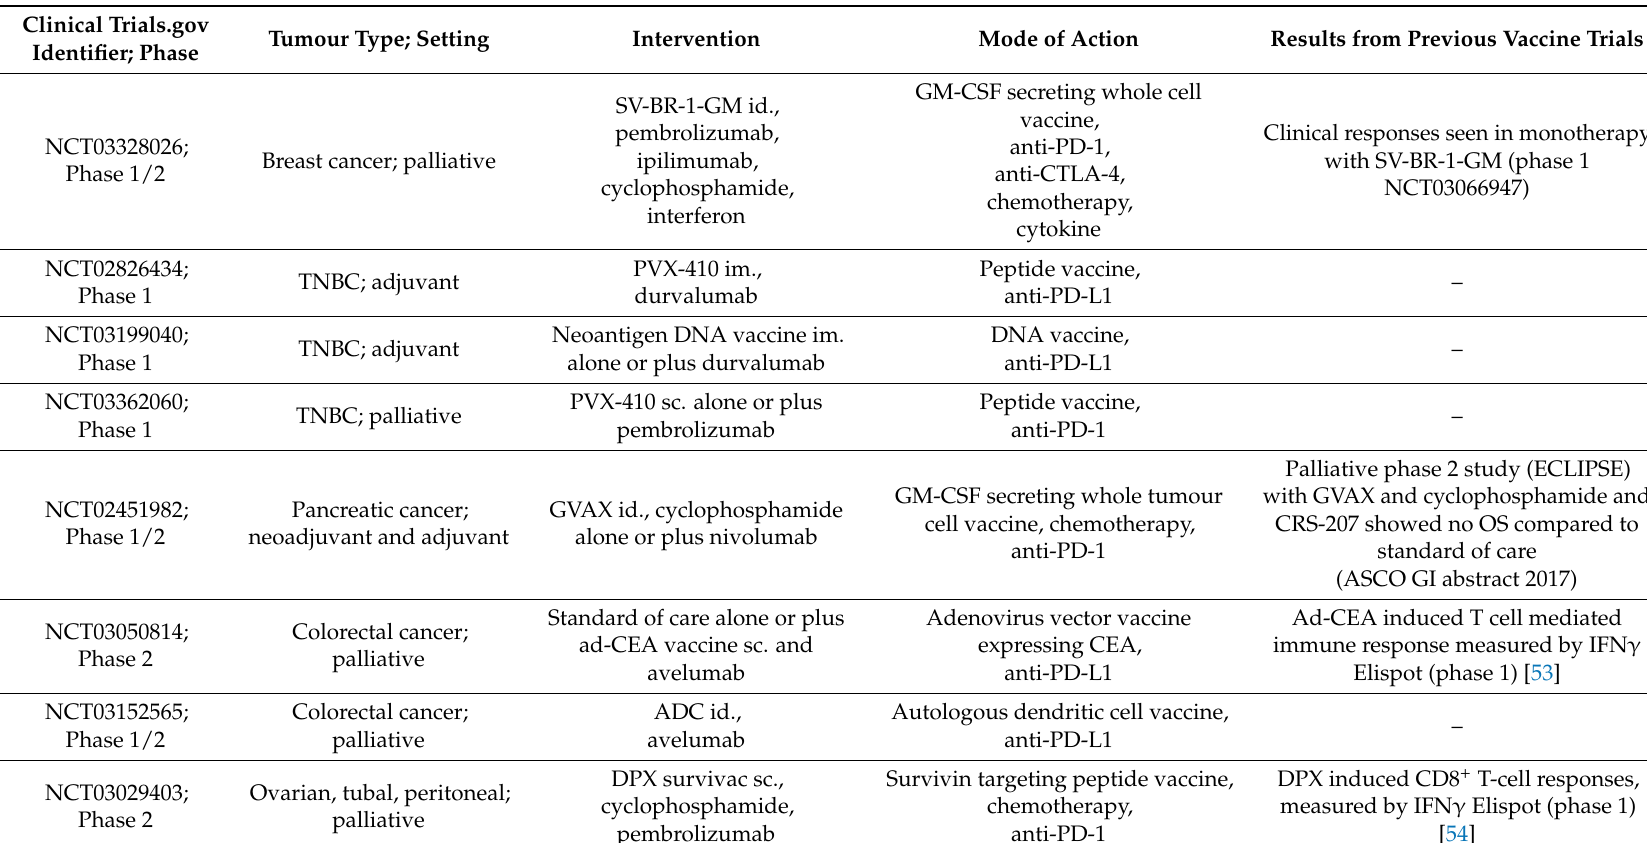
Table 2. Examples of clinical trials combining different type of cancer vaccines with checkpoint inhibitors. The result section gives an overview of results from earlier phase trials if data are available for the specific cancer type. Abbreviations: TNBC, triple negative breast cancer; NSCLC, non-small cell lung cancer; SCLC, small cell lung cancer; OS, overall survival; PFS, progression free survival; WT 1, Wilms tumour gene 1; id, intradermal; im, intramuscular; sc, subcutaneous; iv,